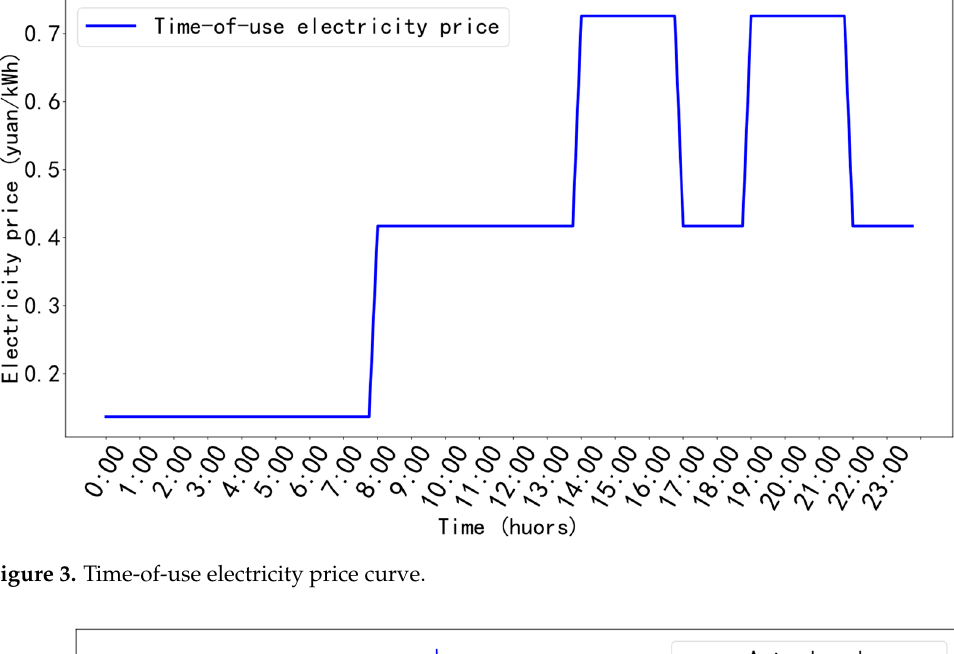
Figure 3. Time-of-use electricity price curve.